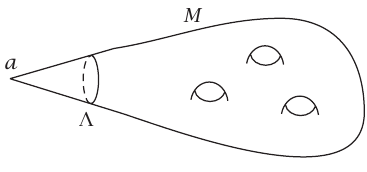
Figure 3.1. A manifold with conical